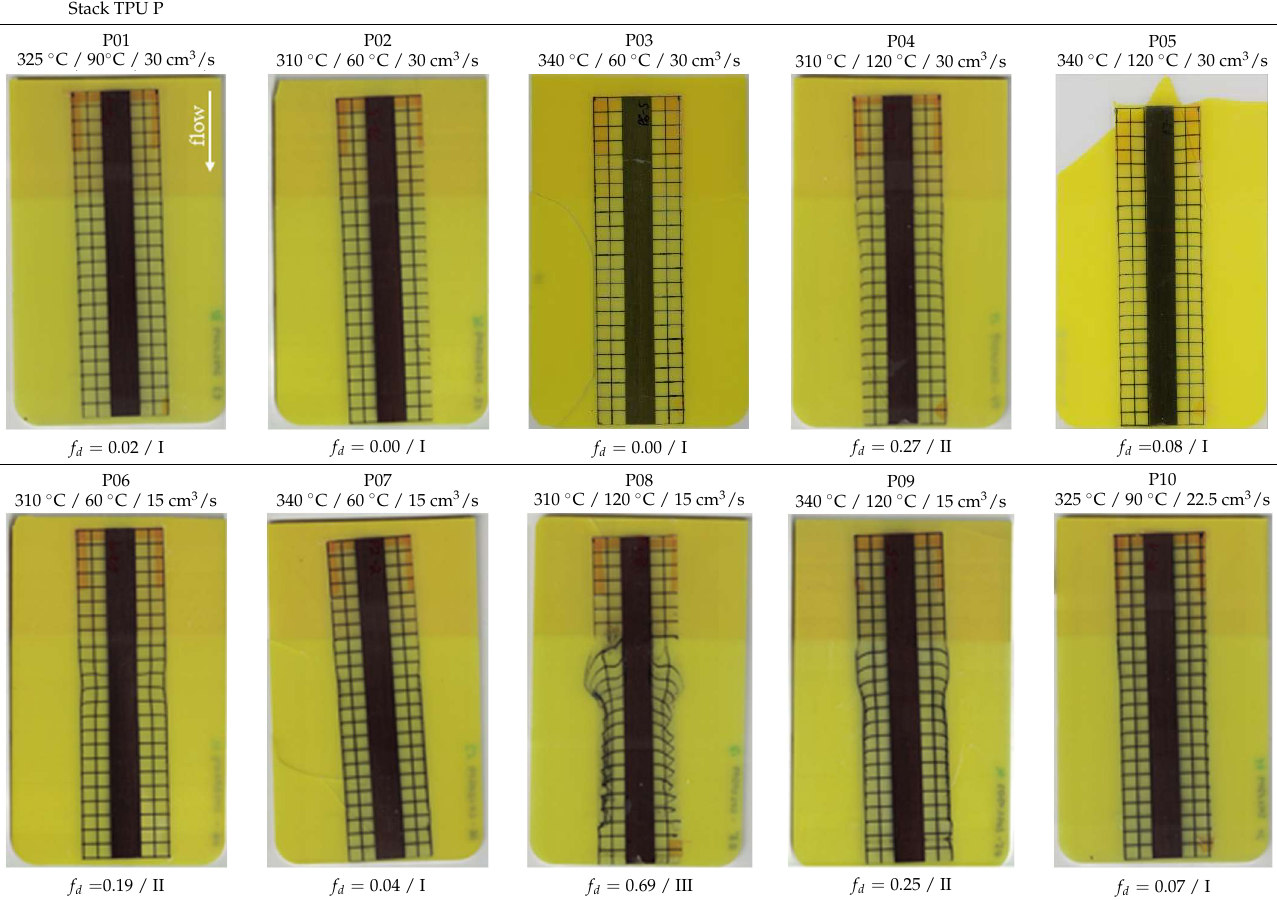
Table 4. ANOVA of DoEs I, II and III in respect to the associated distortion factors f d . Distortion Factors ( f d